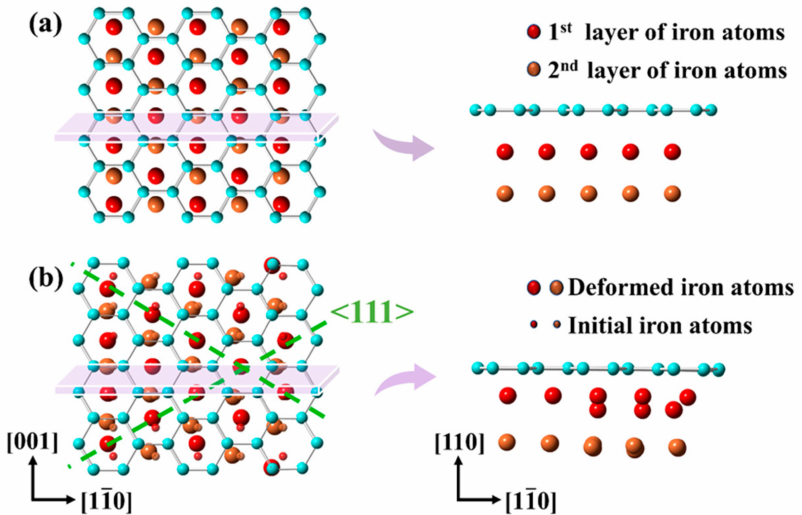
Figure 4. ( a ) Initial and ( b ) the relaxed atomic structures of graphene/Fe (110) interface, correspond- ing to the red region in Figure 3c.